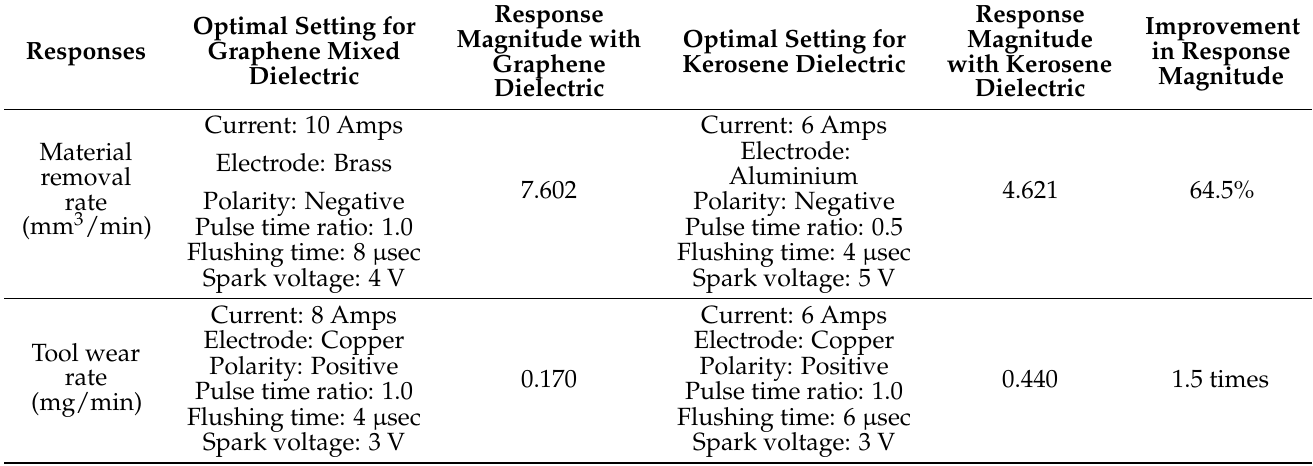
Table 6. Optimal settings with their magnitudes against